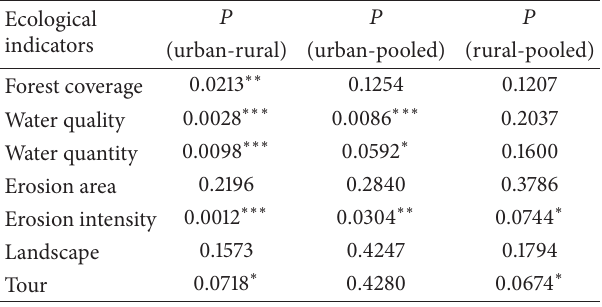
Table 8: Poe et al. [29] test results for implicit prices derived from mixed logit